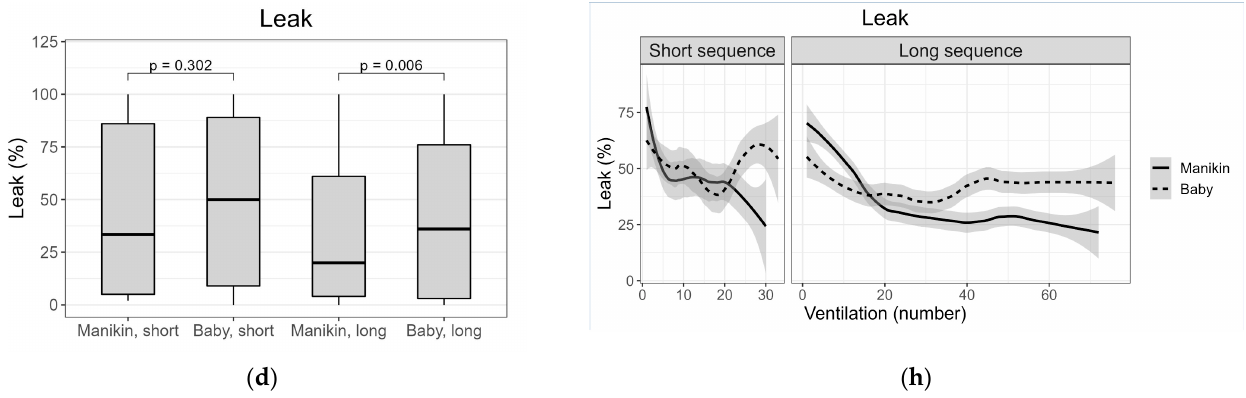
Figure 3. ( a – d ) Box plots of median (interquartile range; range) PIP (peak inflating pressure), PEEP (positive end-expiratory pressure, eV T (expiratory tidal volume) and leak for groups Manikin Short (MS), Baby Short (BS), Manikin Long (ML) and Baby Long (BL); ( e – h ) Dynamical smoothed mean (standard error) plots of PIP, PEEP, eV T and leak for groups MS, BS, ML and BL.